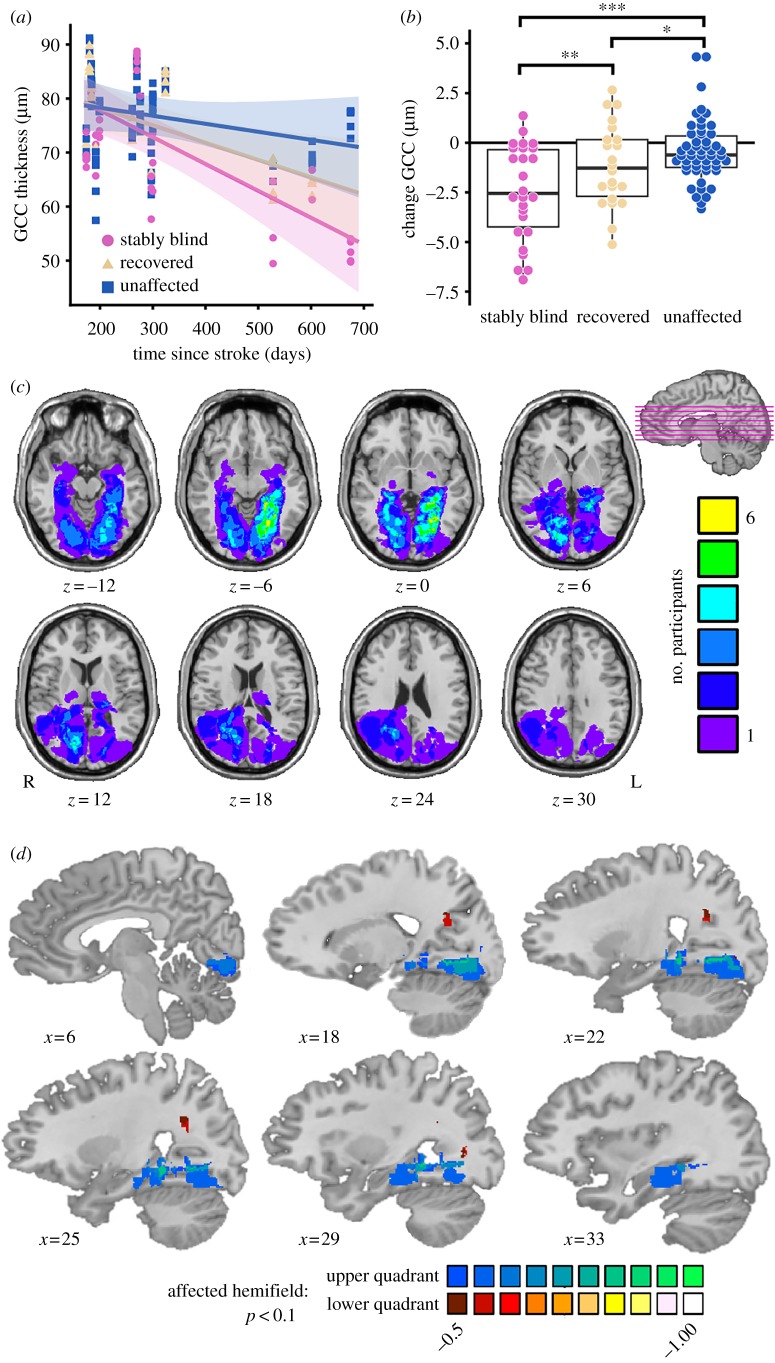
Effect of lesion location, time since stroke, and visual ability on GCC thickness. (a) GCC thickness decreases in the stably blind (pink circle) and recovered (yellow triangle) but not unaffected (blue square) areas of the visual field as a function of time since stroke (n = 15), error is 95% confidence interval. (b) Box plot shows the change in GCC thickness is greatest in stably blind areas of the visual field followed by recovered areas of the visual field (n = 10, *p < 0.05, **p < 0.01, ***p < 0.001). (c) Lesion overlap map of all participants (n = 15) constructed from the acute clinical T2 FLAIR or diffusion-weighted images. (d) Voxel-based lesion-symptom map of the change in GCC thickness (n = 10) in the upper (blues) or lower (reds) quadrant of the affected hemifield (electronic supplementary material). Lesions in the ventral V1 and/or Meyer's loop were associated with greater GCC thinning in the part of the retina that corresponds to the upper visual field; lesions in Baum's loop were associated with greater GCC thinning in the part of the retina that corresponds to the lower visual field (p < 0.1 two-tailed, colour bar is r value for the point-biserial correlation between presence/absence of a lesion and change in GCC thickness).